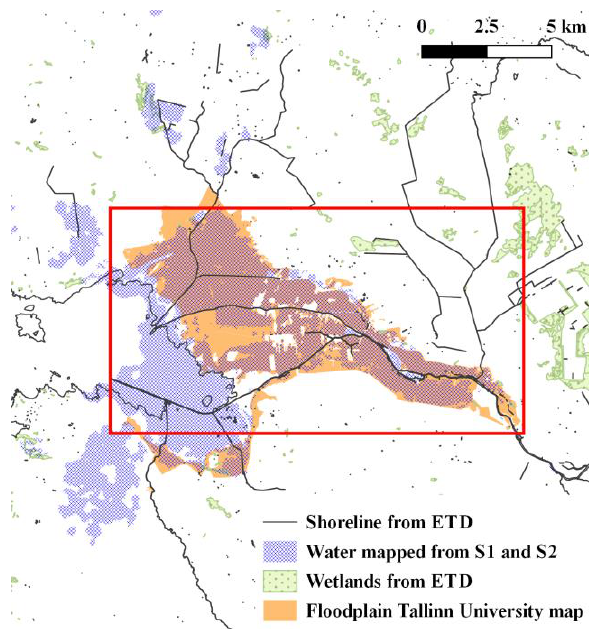
Figure 10. River Kasari on different